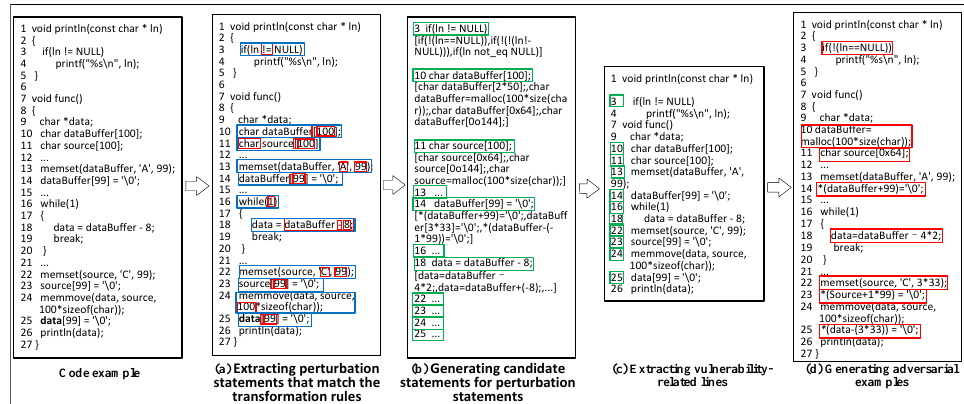
Figure 3. An example illustrating the steps of attack